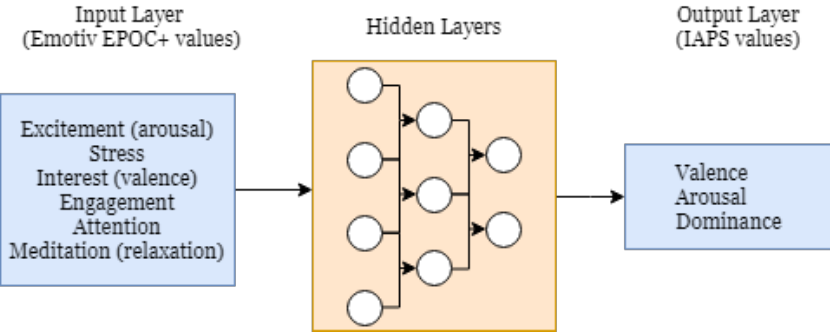
Figure 7. Flowchart of a multilayer perceptron (MLP) artificial neural